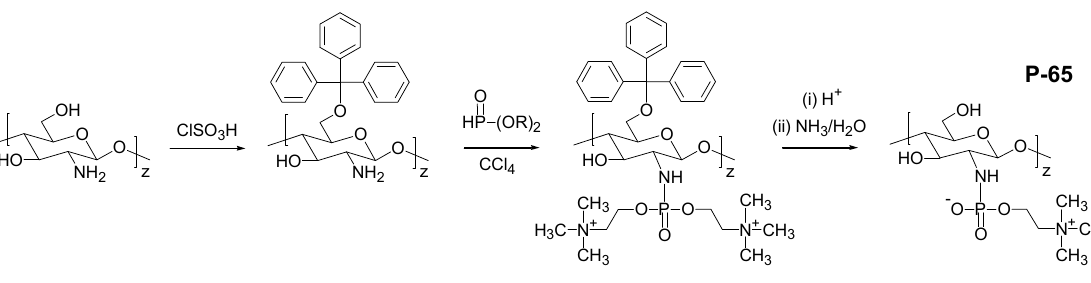
Figure 15. Zwitterionic chitosane derivative made via Atherton-Todd reaction